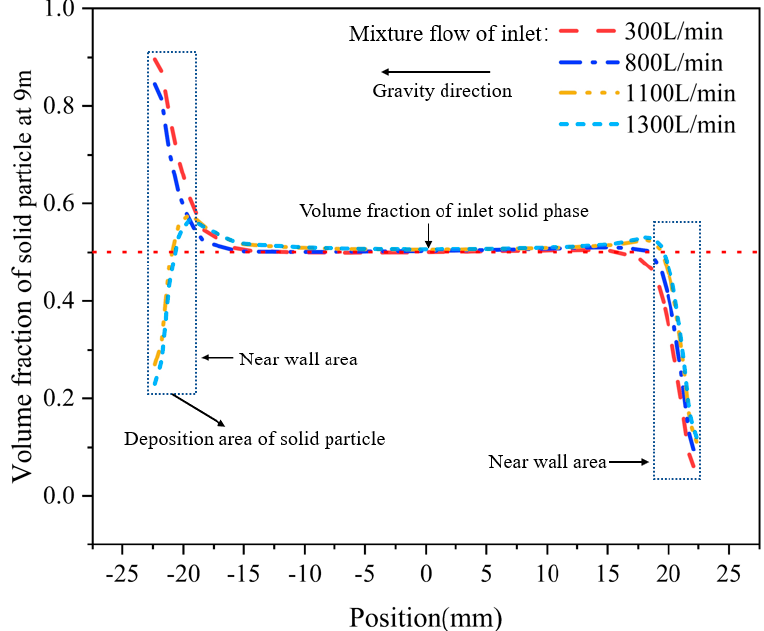
Figure 10. Effect of flow rate of the multiphase mixed slurry of sediment and NGH on the migration.